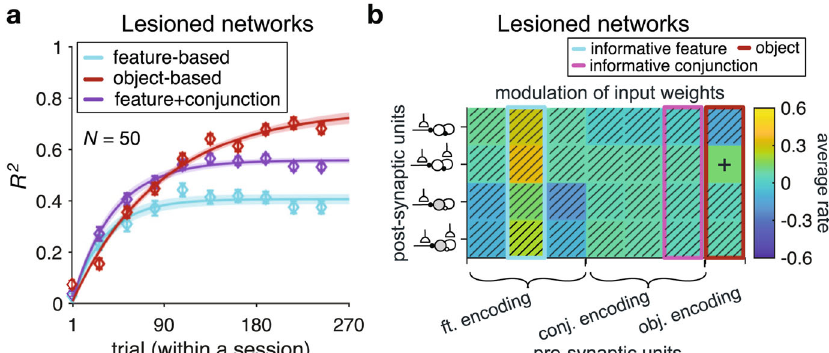
Fig. 8 Lesioning recurrent connections from the inhibitory populations with plastic sensory input (Inh fr and Inh ff ) to the excitatory populations with plastic sensory input (Exc fr and Exc ff ) results in drastic changes in the behavior of the RNNs. a The plot shows the time course of explained variance ( R 2 ) in RNNs ’ estimates based on different models. Error bars represent s.e.m. The solid line is the average of exponential fi ts to RNNs ’ data, and the shaded areas indicate ±s.e.m. of the fi t. b Plotted is the average rate of value-dependent changes in the connection weights from feature-encoding, conjunction-encoding, and object-identity encoding populations to recurrent populations with plastic sensory input (indicated by the inset diagrams explained in Fig. 4b), during the simulation of our task. The plus sign indicates one-sided signi fi cant rate of change (sign-rank test; P < 0.05), whereas hatched squares indicate connections with rates of change that were not signi fi cantly different from zero (two-sided sign-rank test; P > 0.05). Highlighted rectangles in cyan, magenta, and red indicate the values for input from sensory units encoding the informative feature, the informative conjunction, and object-identity, respectively. Source data are provided as a Source Data fi